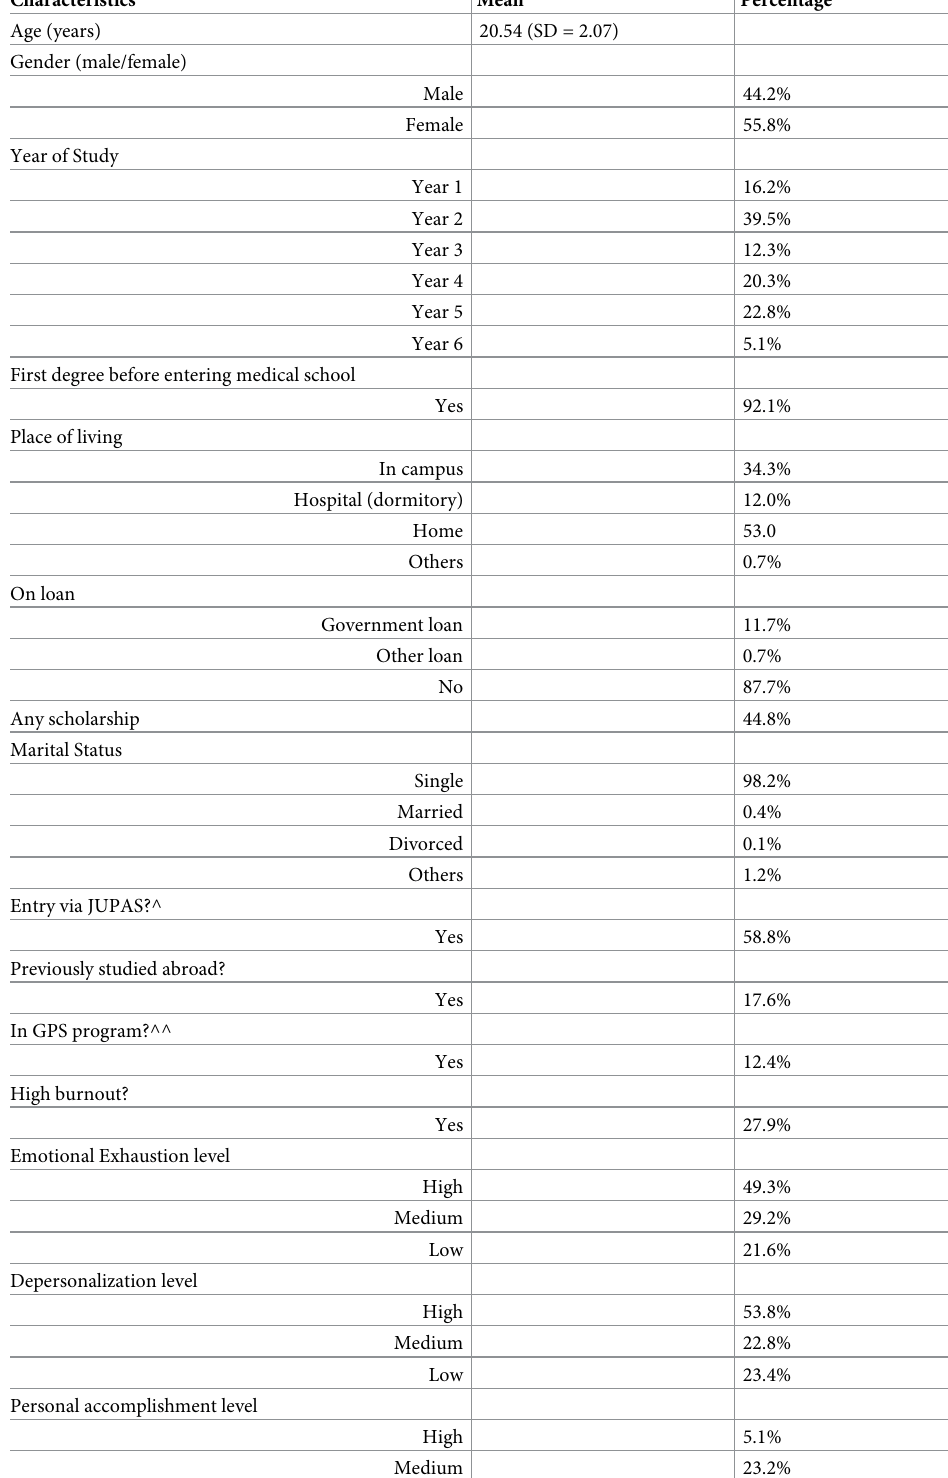
Table 1. Demographics of